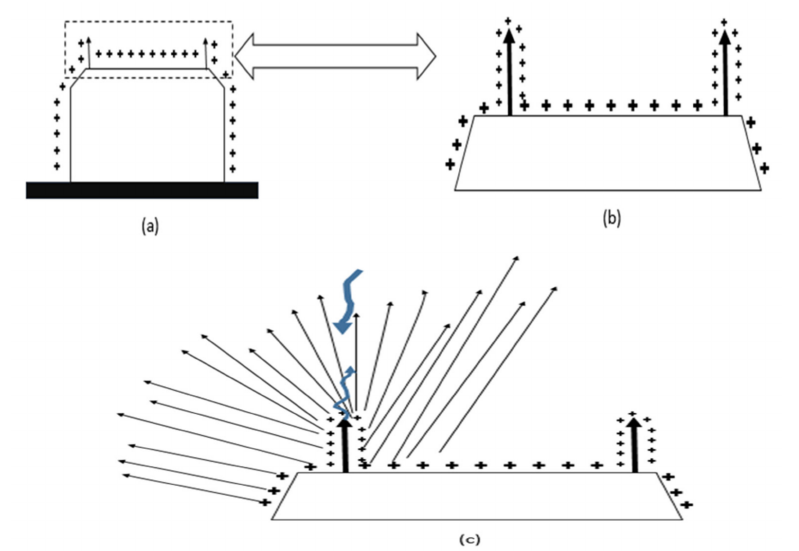
Figure 3. Electrification of grounded building structures with installed LAT during a thunderstorm ( a ) Upper part of the building with distribution of positive charges, ( b ) upper building sectionalized for electric field analysis, ( c ) electric field lines linking the ground and building with ground-to-cloud electric fields (symmetrical consideration), with upward and downward leaders